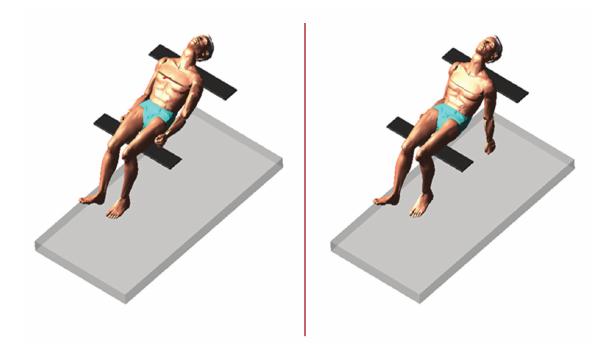
Figure 12: The analysis results for an elderly person and a patient paralyzed on the left side of the